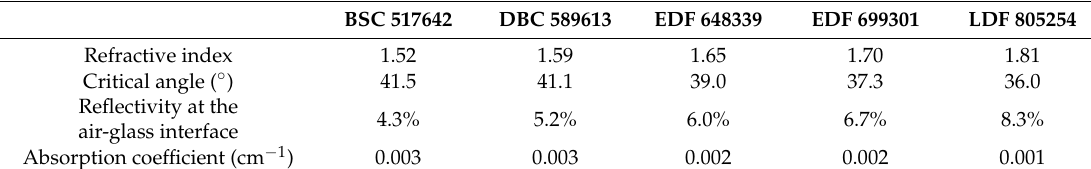
Table 1. Optical properties of the Pilkington optical glasses at the wavelength of 0.54 µ m.